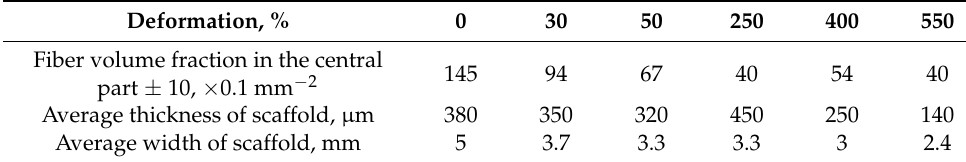
Table 1. Average fiber-packing density data for various deformations of scaffolds, according to ultrasound.